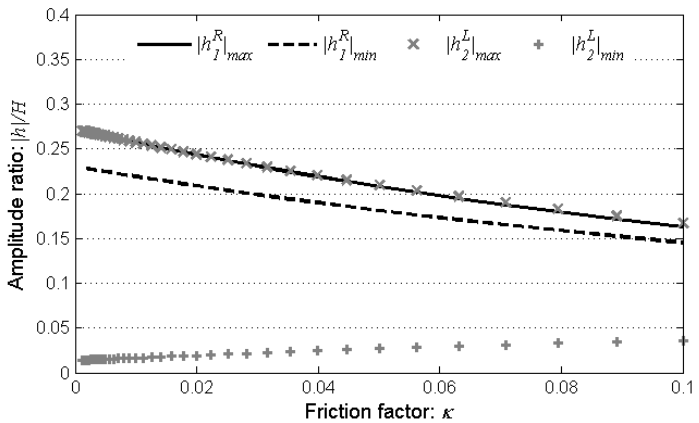
Figure 8. Impact of the Darcy–Weisbach friction factor on the resonances and anti-resonances of the upstream and downstream pressure fluctuations at VSI condition γ 1 =